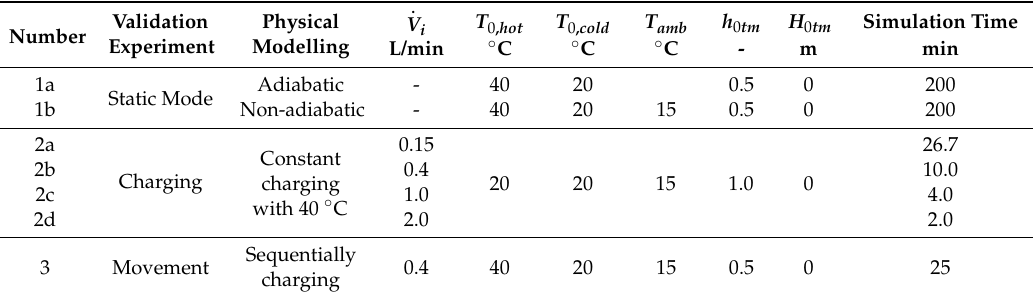
Table 1. Settings and boundary conditions of validation.